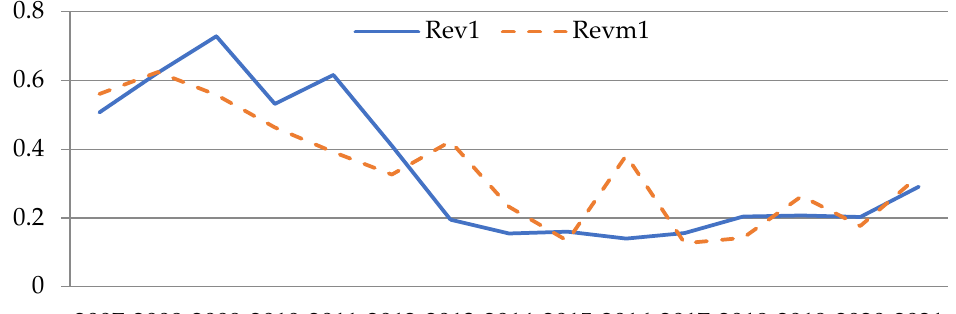
Figure 1. Comparison between real revenue and model value calculated by Formula (1) for industry No. 1 (author’s results).